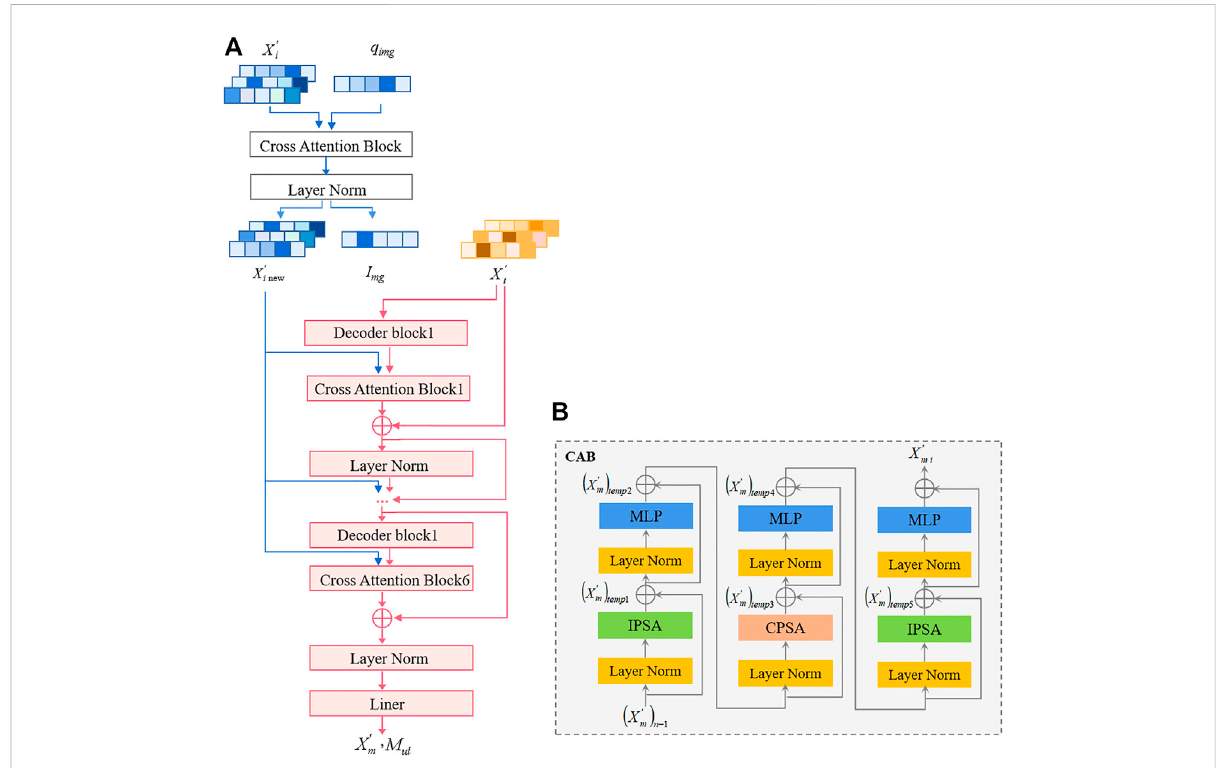
FIGURE 4 MRAN: The input data are the outcome of CCPViT, i.e., the encoded unimodal image features X ′ i and its image query q img , and the decoded unimodal text features X ′ t and its [class_text]token T xt . The multimodal text decoder is used to exploit thelocal and explicit interplay between cross- modality translations. (A) The network structure of MRAN; (B) The network structure of